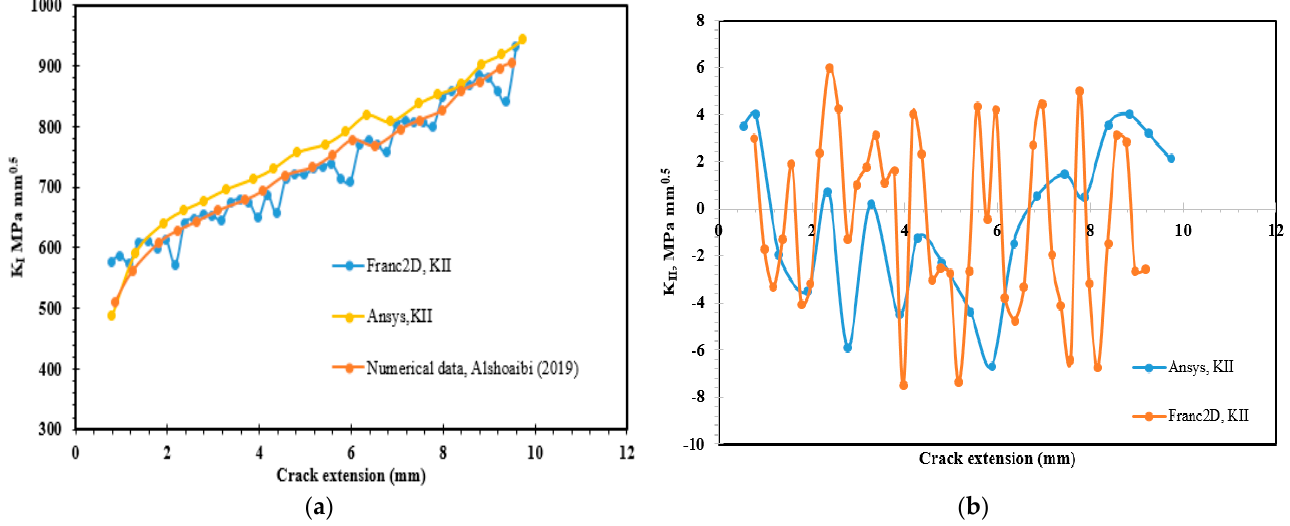
Figure 13. Stress intensity factors with the corresponding crack length for specimen G5, ( a ) K I, and ( b ) K II